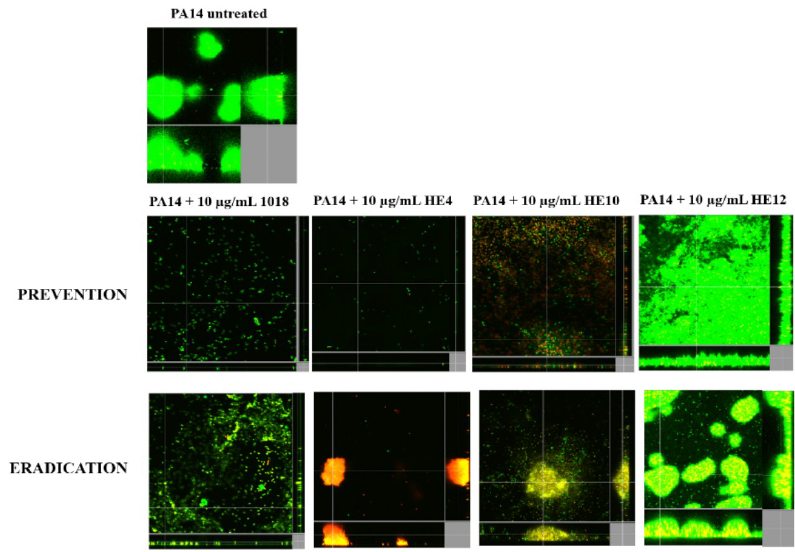
Figure 2. Anti-biofilm activity of peptide 1018 derivatives against P. aeruginosa PA14 in flow cells. For biofilm prevention conditions, the peptides were added to the medium from the beginning of the experiment. For eradication experiments, bacteria were allowed to develop structured 2-day-old biofilms prior to peptide and antibiotics treatment for the following 24 h. After 3 days, bacteria were stained green with the all bacteria stain Syto-9 and red with the dead-bacteria stain propidium iodide (merge shows as yellow to red) prior to confocal imaging. Each panel shows reconstructions from the top in the large panel and sides in the right and bottom panels (xy, yz, and xz